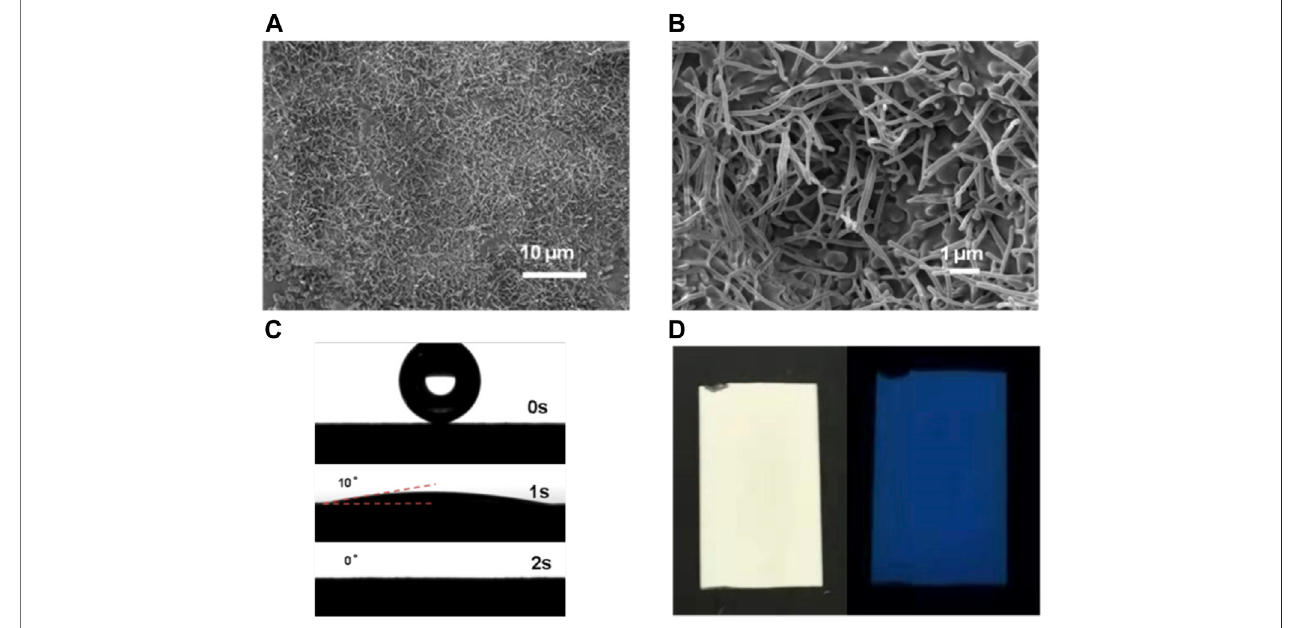
FIGURE 1 | (A, B) SEM images, (C) optical contact angle images of water, and (D) fl uorescence images of g-C 3 N 4 fi lm,